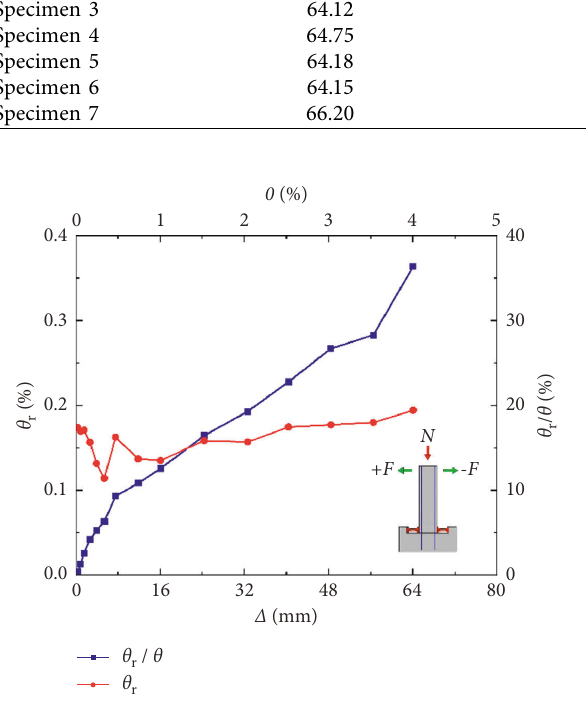
Figure 21: The relationship between θ and θ